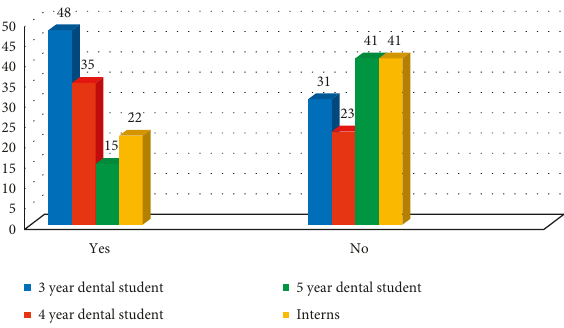
Figure 6: Awareness of participants toward the international recommendations from the ICRP ( χ 2 Table 2: Dental unit operator must stand at least six feet from the useful beam or behind a protective barrier. Operator position in a dental